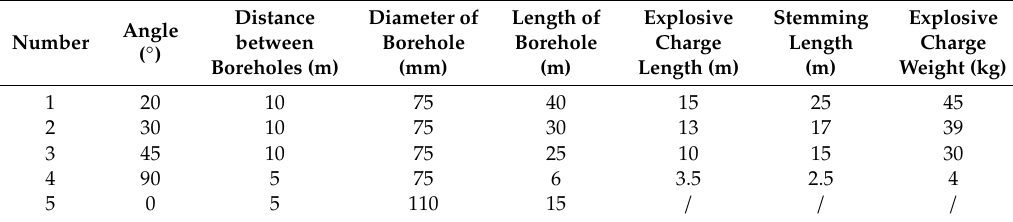
Figure 15. Layout of technical scheme for rock burst prevention in the 5521-20 working face: ( a ) Plan of the technical scheme; and ( b ) profile of the technical scheme. Table 4. Design parameters for the 1#–5# holes.